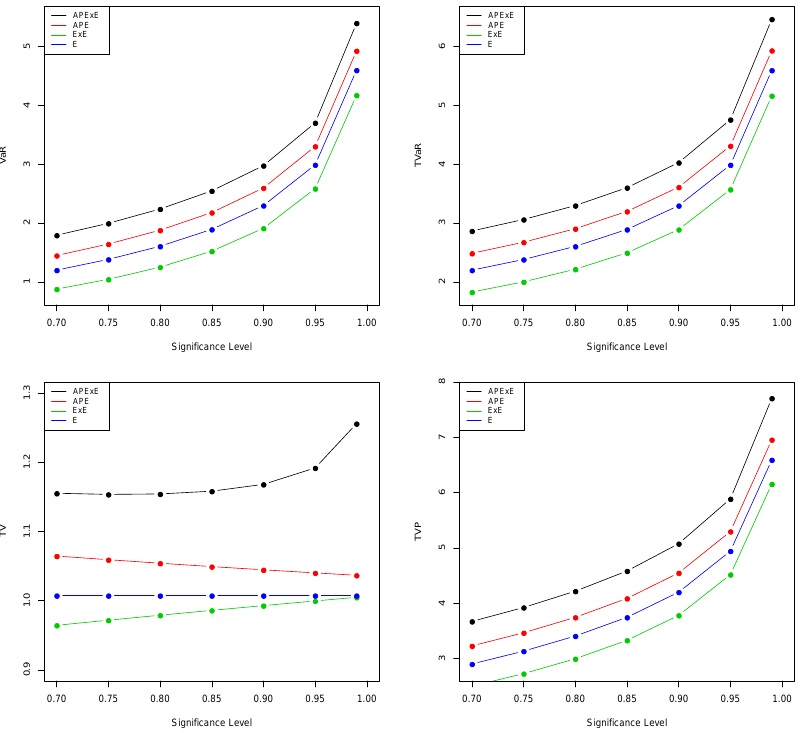
Figure 5. Plots of the VaR, TVaR, TV, and TVP using the values in Table